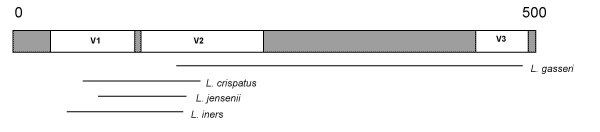
Localisation of the primers used in this study on the 16S rRNA gene.